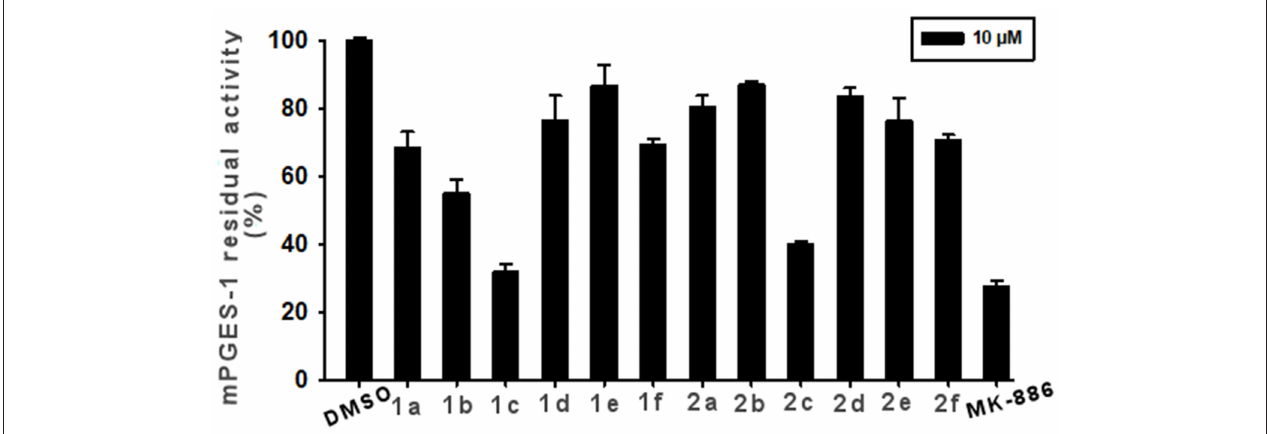
FIGURE 6 | Inhibition of mPGES-1 by compounds 1a - f , 2a - f , and MK-886 (10 µ M) in a cell-free enzyme activity assay. The percentage of residual mPGES-1 activity is calculated with respect to the control. Data are given as mean ± SEM, n = 3.